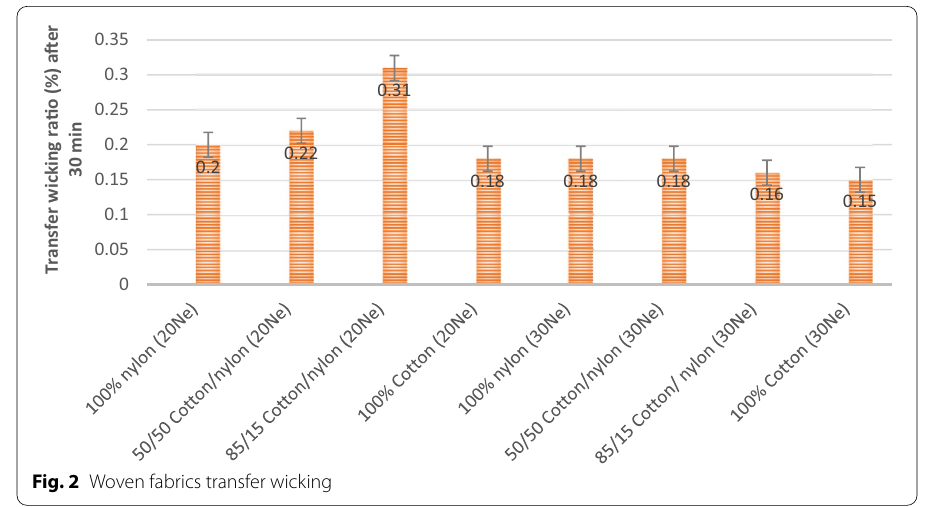
Fig. 2 Woven fabrics transfer wicking